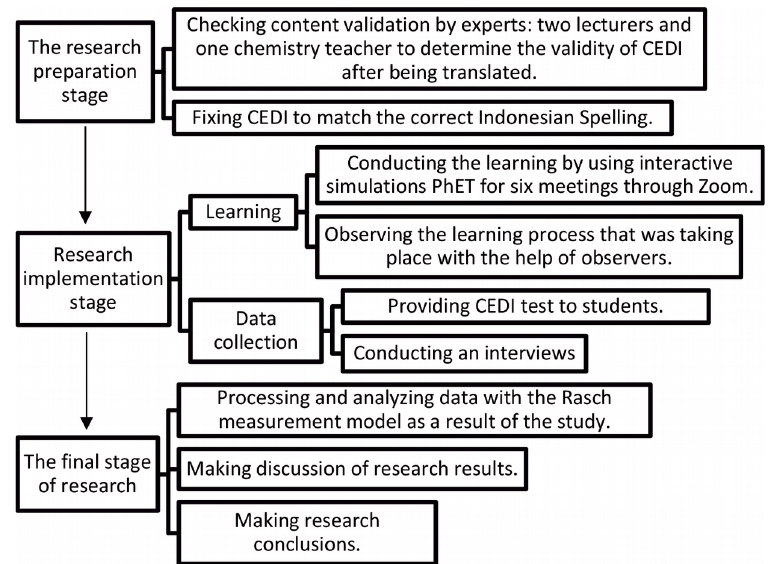
Figure 1. Research and learning